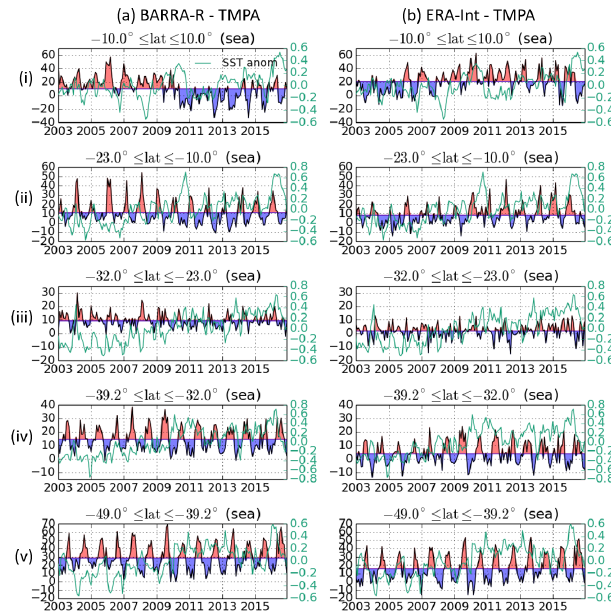
Figure 10. Differences in monthly precipitation total (mm) av- eraged over the ocean in five sub-domains (rows i–v) between (a) BARRA-R and TMPA and between (b) ERA-Interim and TMPA. Black curves are shaded around the 14-year means. Green curves plot the monthly anomalies, from 2003–2016 monthly aver- ages, of the OSTIA sea surface temperature averaged over respec- tive